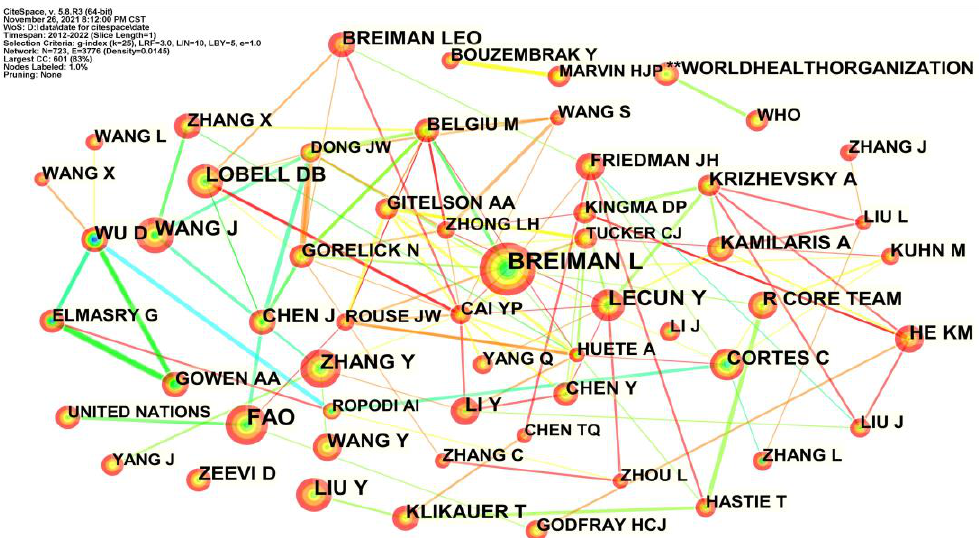
Figure 5. The author co-citation network of AI-related publications.